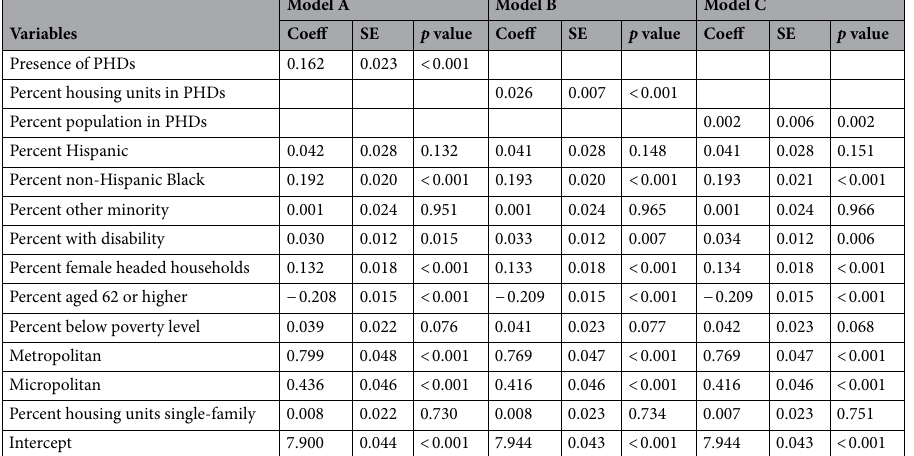
Table 2. Multivariable generalized estimating equations (GEEs) for predicting census tract PM 2.5 concentrations. N = 61,117 tracts in counties of continental US with public housing. Model specifications are gamma with identity link with an unstructured correlation matrix with controls for clustering in terms of county by median decade of housing stock (7492 clusters). SE is standard error and all p values are based on Wald Chi-Square test. Independent variables were standardized.